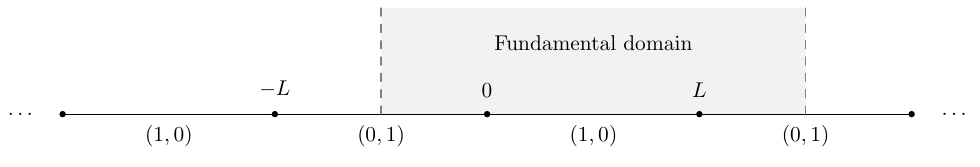
Figure 2 . Rod structure for Example